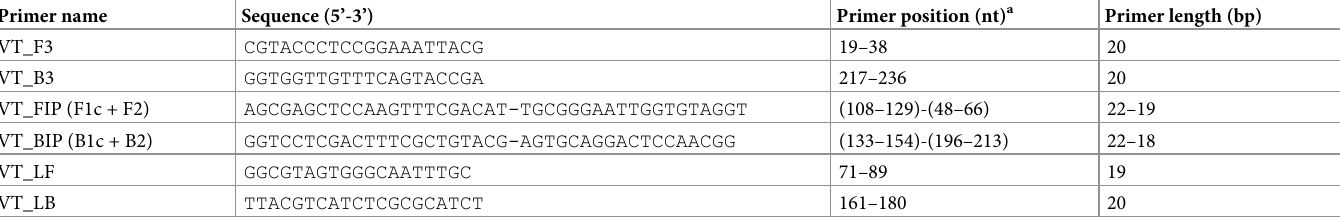
Table 1. Primers used for the RT-LAMP assay for VT strains of Citrus tristeza virus